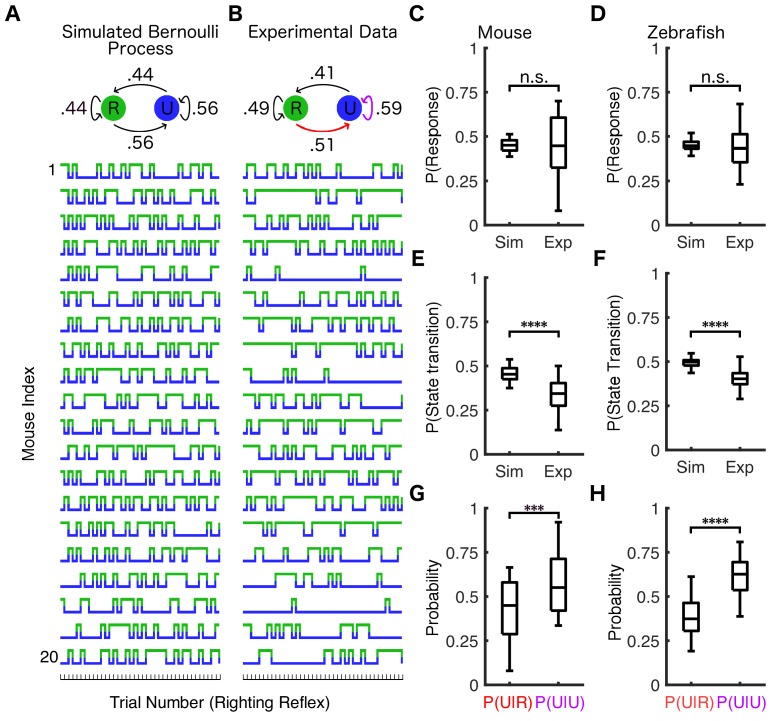
Response probability is state-dependent.(A) Twenty simulations of a Bernoulli process where the response probability is 44% for all trials (identical to the average PRP in mice at 0.6% isoflurane) were performed. Each simulation consisted of the same number of trials as the experimental data from (B). Similar simulations were conducted for zebrafish using PRP of 0.45. Simulated (A) and experimentally observed (B) transition probability matrices are shown schematically above traces. The population response probability in simulations is not statistically different from experimental observations across mice (C) (U = 197.5, nsim = nexp = 20, p=0.95) or across zebrafish (D) (U = 2276, nsim = nexp = 72, p=0.34). Both mice (E) (U = 48.5, nsim = nexp = 20, p<0.0001) and zebrafish (F) (U = 300.5, nsim = nexp = 72 p<0.0001) have fewer state transitions than simulations of the Bernoulli process. Both mice (G) (U = 103, nP(U|R) = nP(U|U)=20, p<0.001) and zebrafish (H) (U = 501, nP(U|R) = nP(U|U)=72, p<0.0001) are more likely to stay unresponsive if they failed to respond in the previous trial (purple arrow in B) than if they were able to respond to the previous stimulus (red arrow in B). In plots (C–H) box plots show inter-individual differences in estimated parameters (central mark indicates the median, box shows interquartile range, whiskers extend to the most extreme data points). Statistical significance is shown by ***p<0.001 ****p<0.0001. Source data for all quantitative analyses described are available in the Figure 3—source data 1.Figure 3—source data 1.Individual simulated and experimental response probabilities and probability of transitions (total, P(U|U), and P(U|R)).